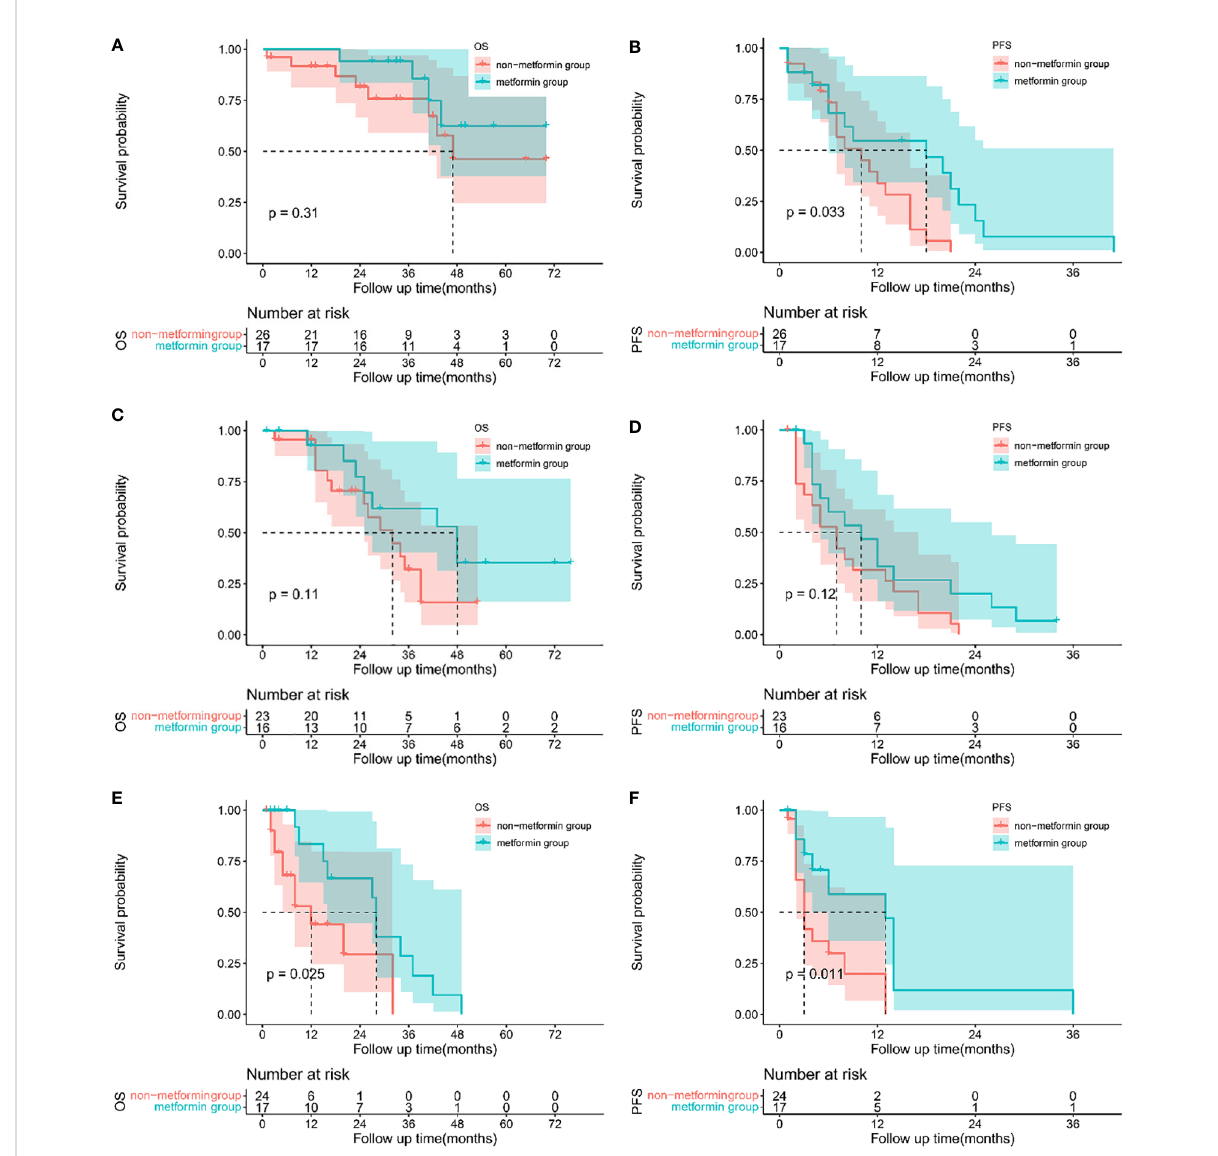
FIGURE 2 Sub-group analysis: Kaplan-Meier plots comparing metformin users versus non-metformin users among HCC patients with T2DM undergoing TACE based on BCLC staging system. Overall survival curves of patients with BCLC stage A (A) , stage B (C) and stage C (E) , and progression-free survival curves of patients for BCLC stage A (B) , stage B (D) and stage C (F)